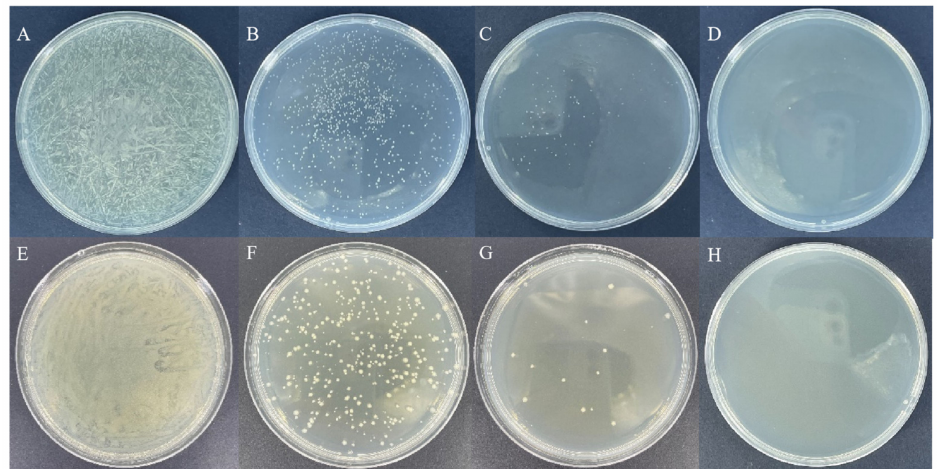
Figure 1. Growth condition of ds RcOrco -HT115 on medium after sonication. ds RcOrco -HT115